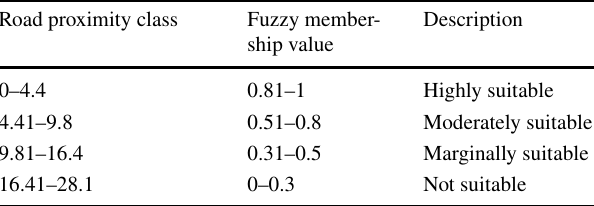
Fig. 12 Fuzzy membership values for a rainfall deficit, b road proximity Table 9 Criteria for classification of road proximity deficit to rivers in the study area